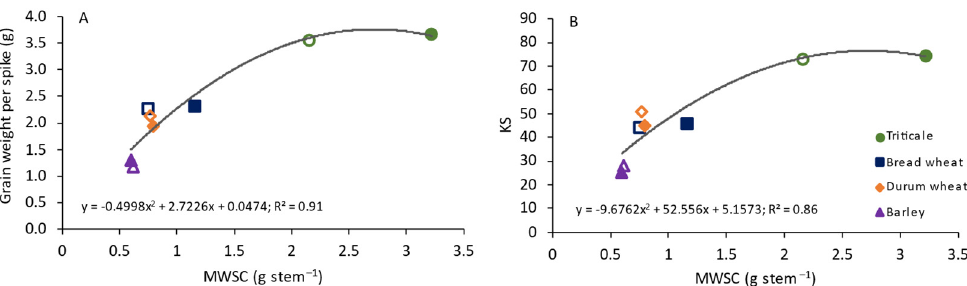
Figure 6. Relationship between the mobilisation of water-soluble carbohydrate (MWSC) and ( A ) grain weight per spike at maturity and ( B ) kernel per spike (KS) in four cereals (triticale, bread wheat, durum wheat and barley) grown under well-watered (closed symbols) and water-limited (open symbols) regimes.